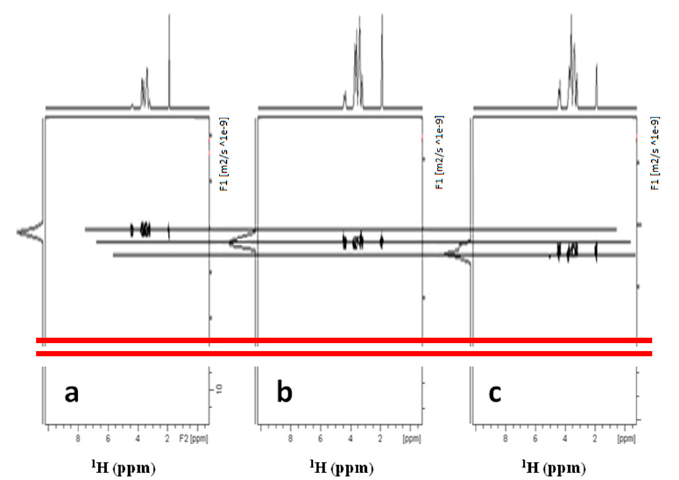
Figure 4. DOSY experiments of three different HA polymer standards in D2O with different MWs. ( a ) 13 kDa; ( b ) 50 kDa; ( c ) 208 kDa. To avoid confusion due to possible interferences, the experiments were run on single polymer samples. The diffusion coefficient obtained are used for the calibration curve in the log-log plot of the Figure 5.